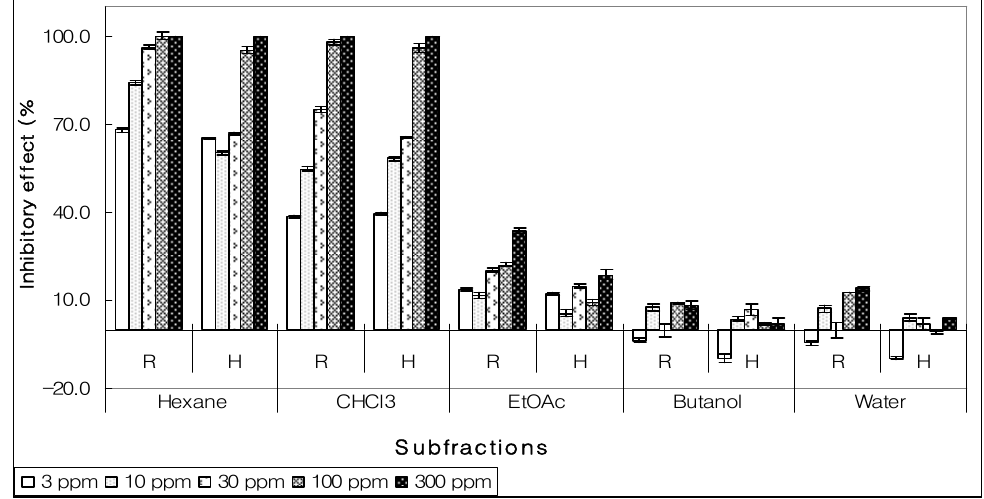
Figure 2. Allelopathic effect of various subfractions on growth of root (R) and hypocotyls (H) of lettuce seeds at different concentrations.